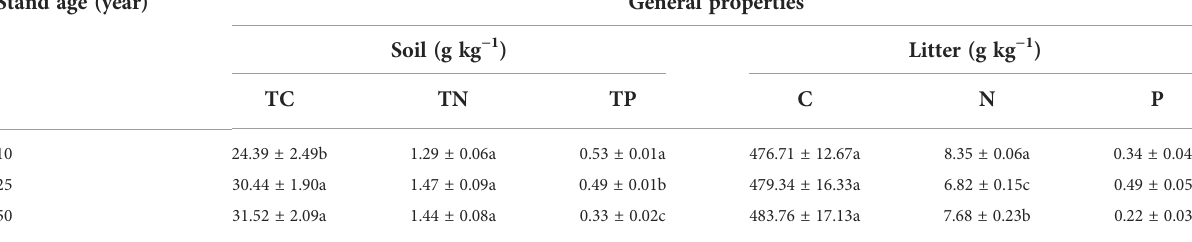
TABLE 1 General properties of litter and soil in different-aged stands of larch plantation. Stand age